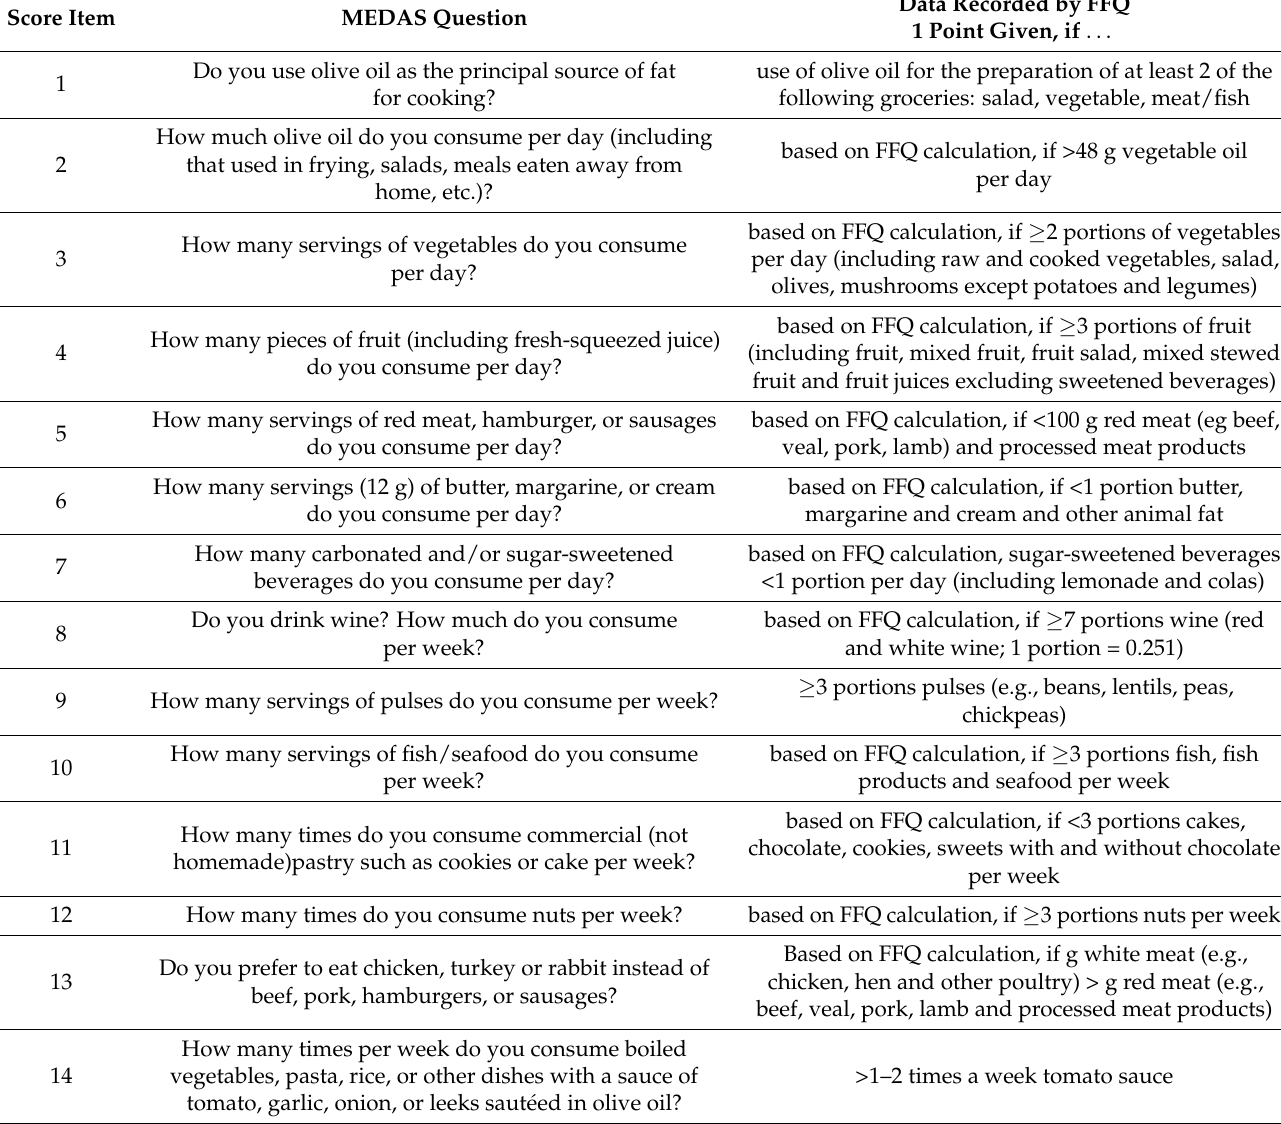
Table A1. Scoring criteria for Mediterranean Dietary